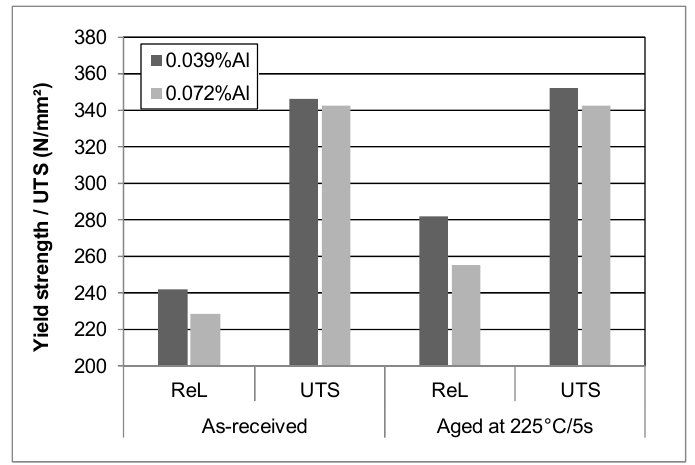
Figure 4. The effect of increased Al content on yield strength and UTS.